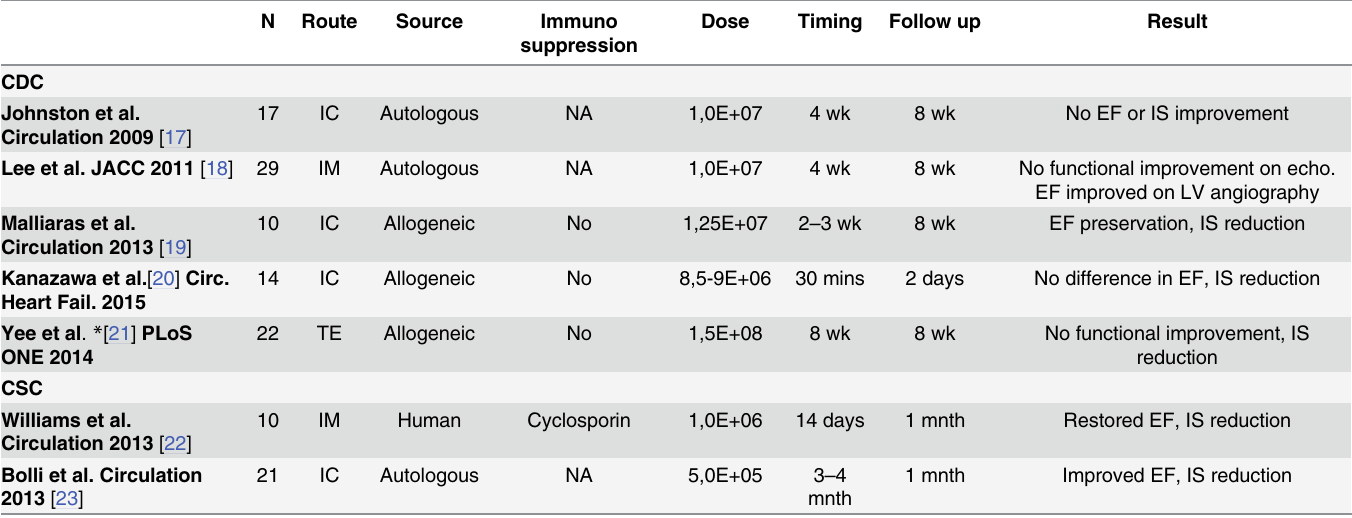
Table 3. Overview of studies of cardiac derived stem cells in pig